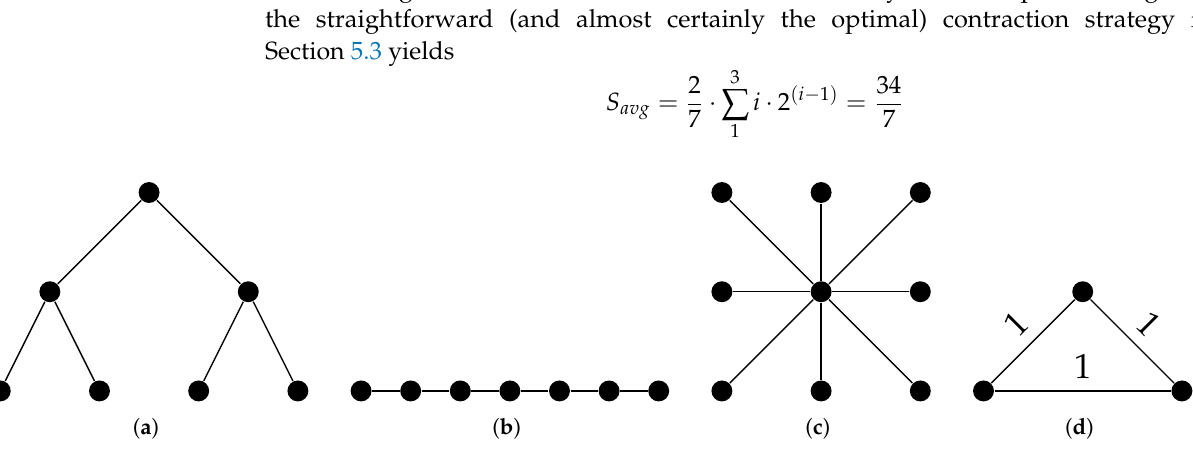
Figure 10. Example for Graphs. ( a ) Balanced binary tree; ( b ) Path graph; ( c ) Star graph; ( d ) Triangle